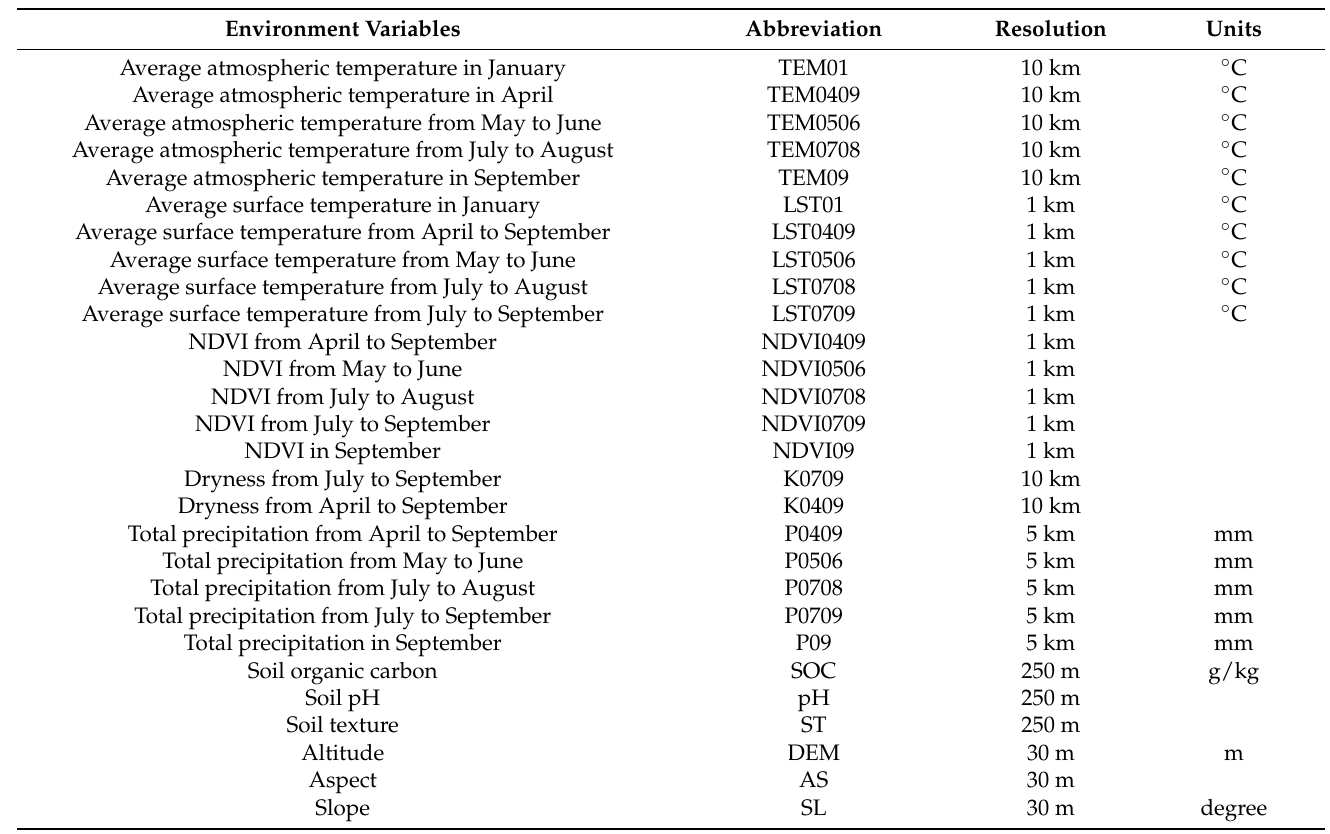
Table 1. Definition of environment